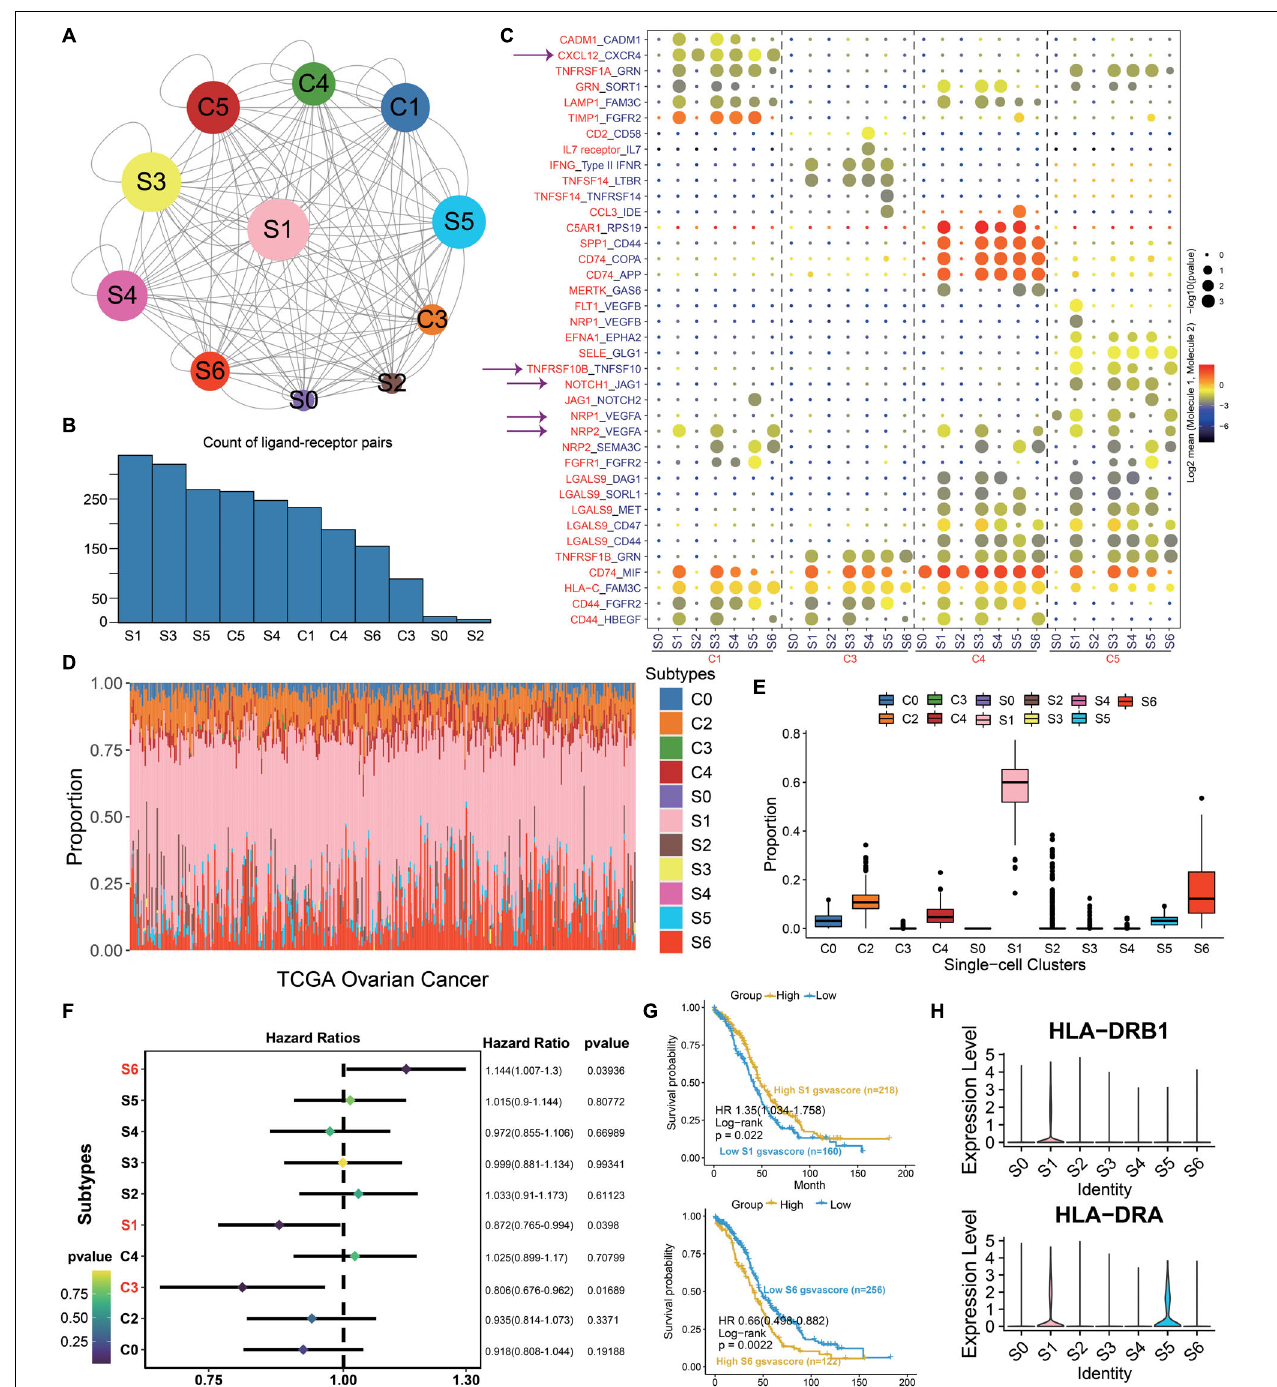
FIGURE 3 | S1 is the dominant subtype in malignant epithelial subgroups. (A) Interaction network constructed by CellPhoneDB; circle size represents interaction counts. (B) Bar plot illustrating the count of ligand–receptor pairs. (C) Dot plot showing ligand–receptor pairs of malignant epithelial subgroups and other clusters. (D) Stacked bar plot summarizing cell subtype fractions with the deconvolution result of 379 OCs from TCGA. Colors of the bars represent 11 cell states as shown in the legend. The y -axis represents the proportion of each state in a tumor sample. In the x -axis, each column represents one tumor case. (E) Box plot illustrating the proportion of each state in TCGA OC samples. (F) Association between relative abundance of cell states calculated by CIBERSORT and survival. (G) Kaplan–Meier curves for the relative abundance of S1 and S6. (H) Violin plots exhibiting the MHC molecules such as HLA-DRB1 and HLA-DRA across different subtypes. The y -axis was the normalized read